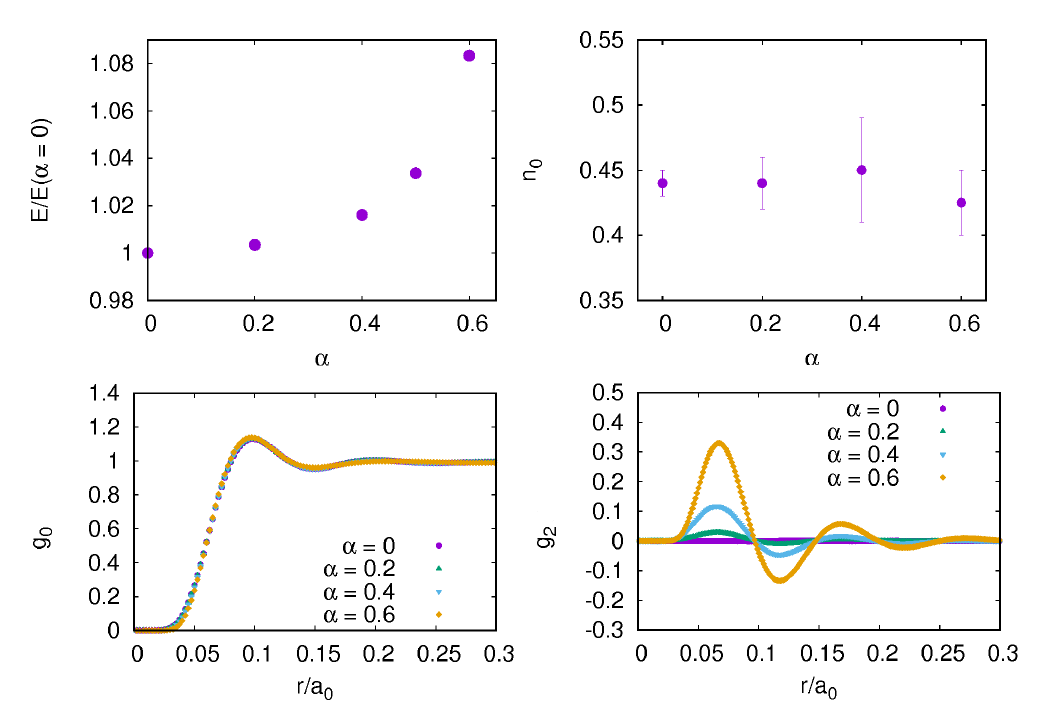
Figure 8: Ratio of the bulk DMC energy per particle, in units of the scattering length ( α ) to E ( α = 0, x ) , for x = 100 (top left panel). Condensate fraction as a function a 0 of the tilting values α for x = 5 (top right panel). Isotropic (bottom left panel) and first anisotropic modes (bottom right panel) of the pair distribution function for x = 100. All quantities have been computed for the Hamiltonian of Eq. 14, where a short range repulsive potential is considered along the